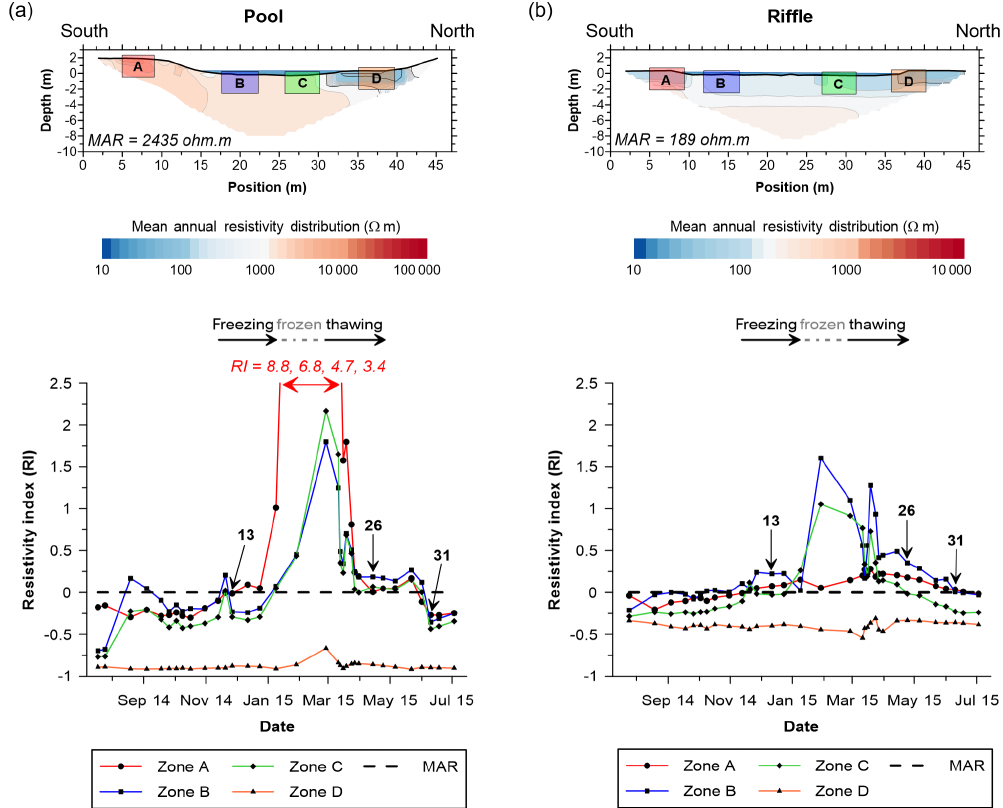
Figure 11. Spatiotemporal fluctuations in resistivity within the focused monitoring zones A, B, C, and D. The resistivity index (RI) was calculated using Eq. (3), using the mean zone resistivity (MZR) for a given measurement date and the mean annual resistivity (MAR) of the whole